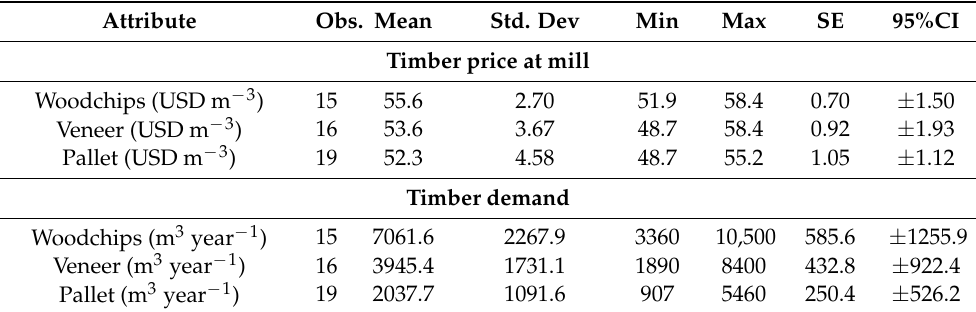
Table 2. Mean timber price and demand and their descriptive statistics. Attribute Obs. Mean Std. Dev Min Max SE 95%CI Timber price at